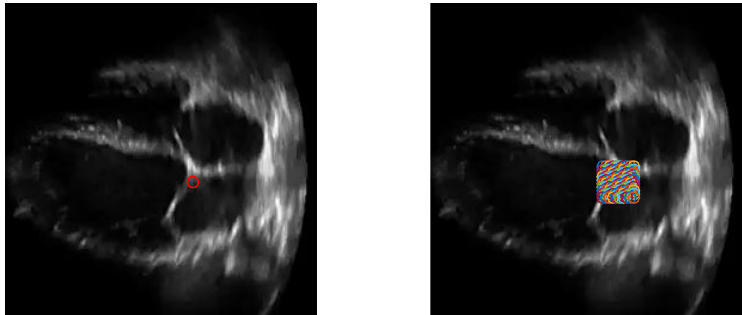
Figure 15. An ultrasound image with one initialization point ( left ) and 100 points ( right